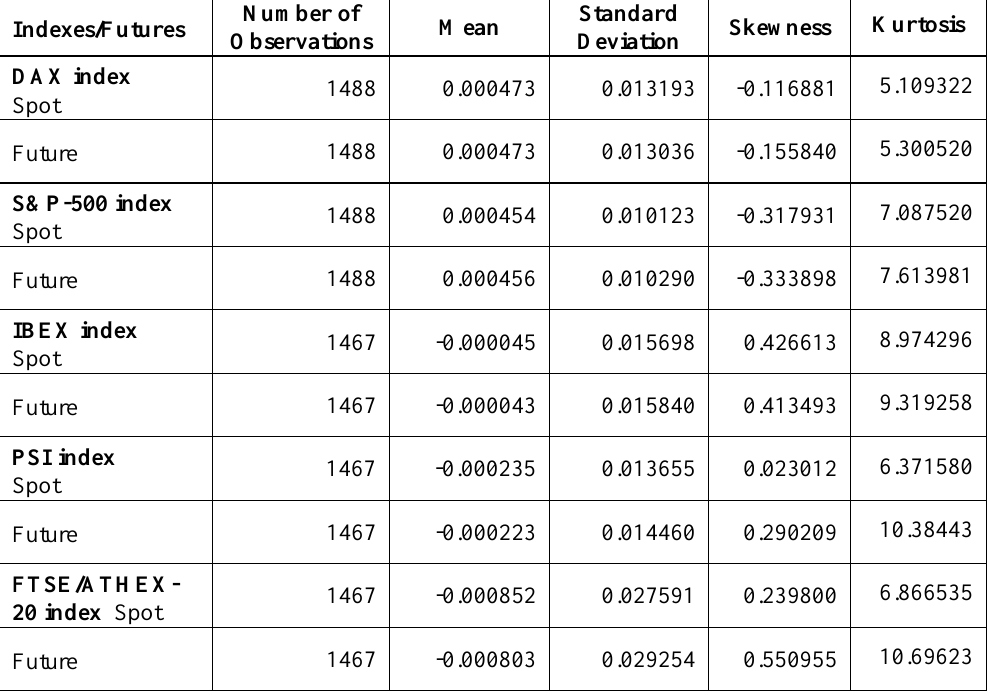
Table 1. Summary